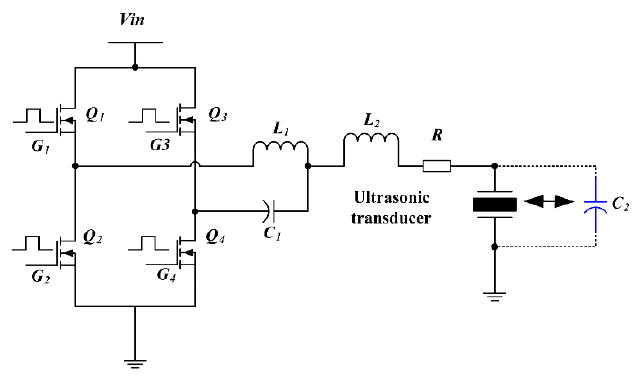
Figure 4. Schematic of the proposed converter.